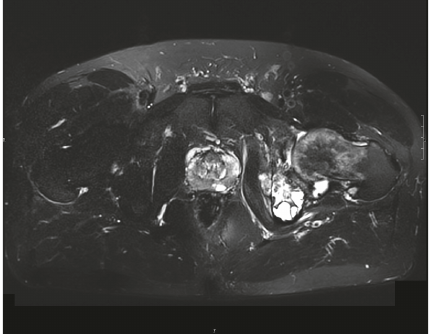
Figure 2: MRI: T2-weighted sequence.